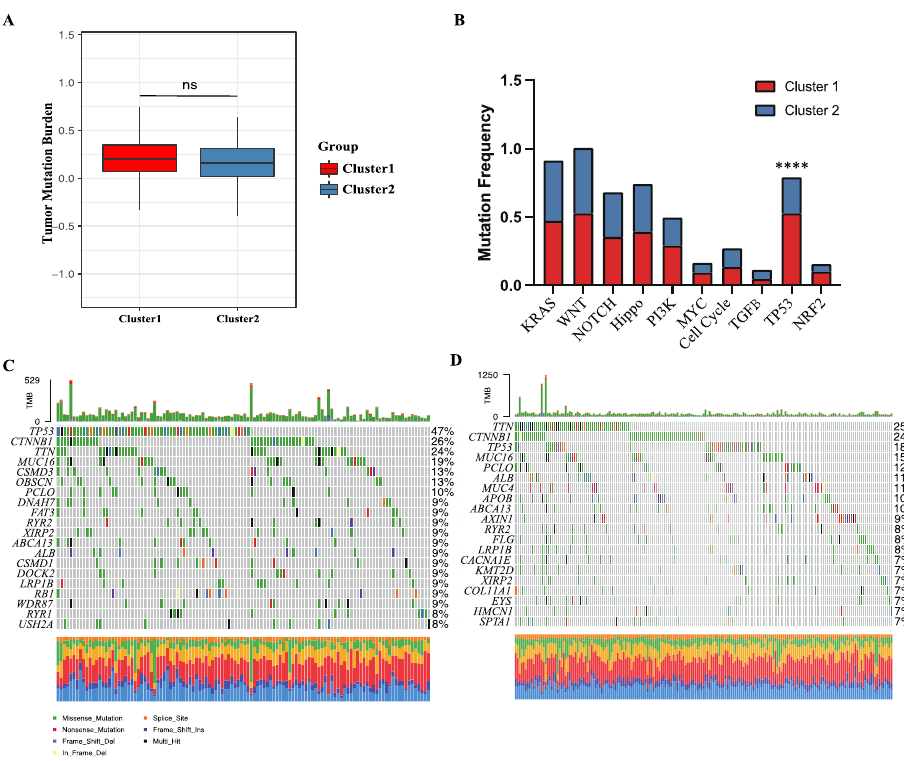
Figure 3. Comparison of the somatic mutation frequency alteration in two clusters. ( A ) Quantification of the tumor mutation burden in two clusters. ( B ) Mutation frequency of 10 classical oncogenic pathways. ( C , D ) The 20 genes with the highest mutation frequency in cluster 1 ( C ) and cluster 2 ( D ) in OncoPrint. ns, p value > 0.05; ****, p value < 0.0001.